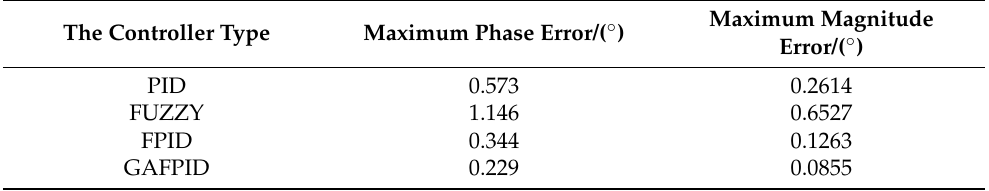
Table 5. Simulation data of the frequency response under